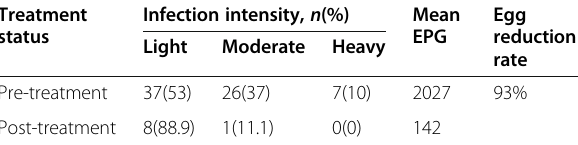
Table 3 Hookworm infection intensity and egg reduction rates in pre- and post-treatment periods among study participants Treatment